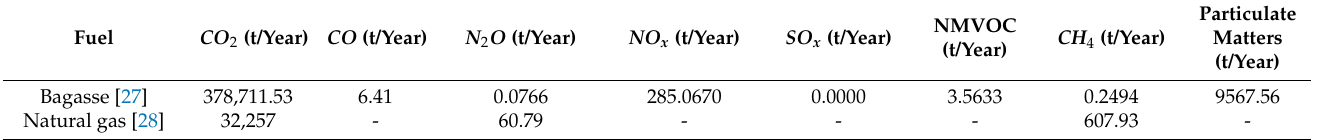
Table 8. Emissions from biomass burning of the process under